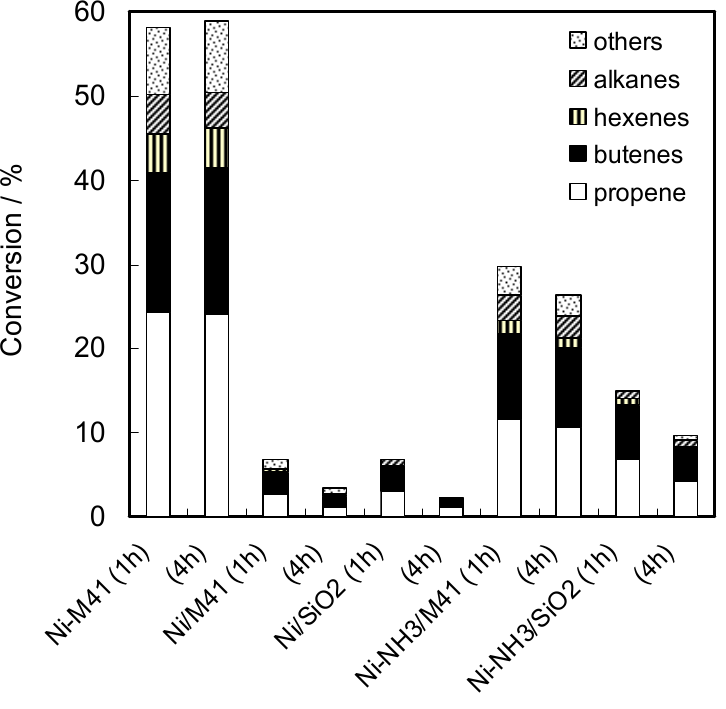
Figure 7. Catalytic activity of nickel-ion loaded catalysts for the ETP reaction at 673 K. The reaction times after the beginning of the reaction are described in the parentheses.